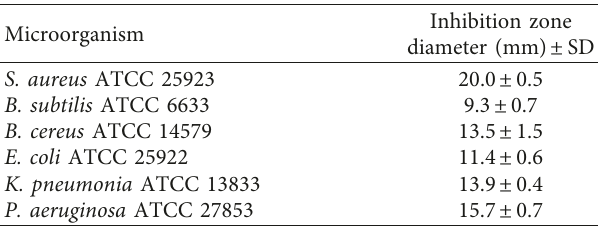
Table 2: Inhibition zone diameter of lipopeptides against various reference bacterial strains. Results are expressed as the mean value of three independent experiments ± standard deviations.